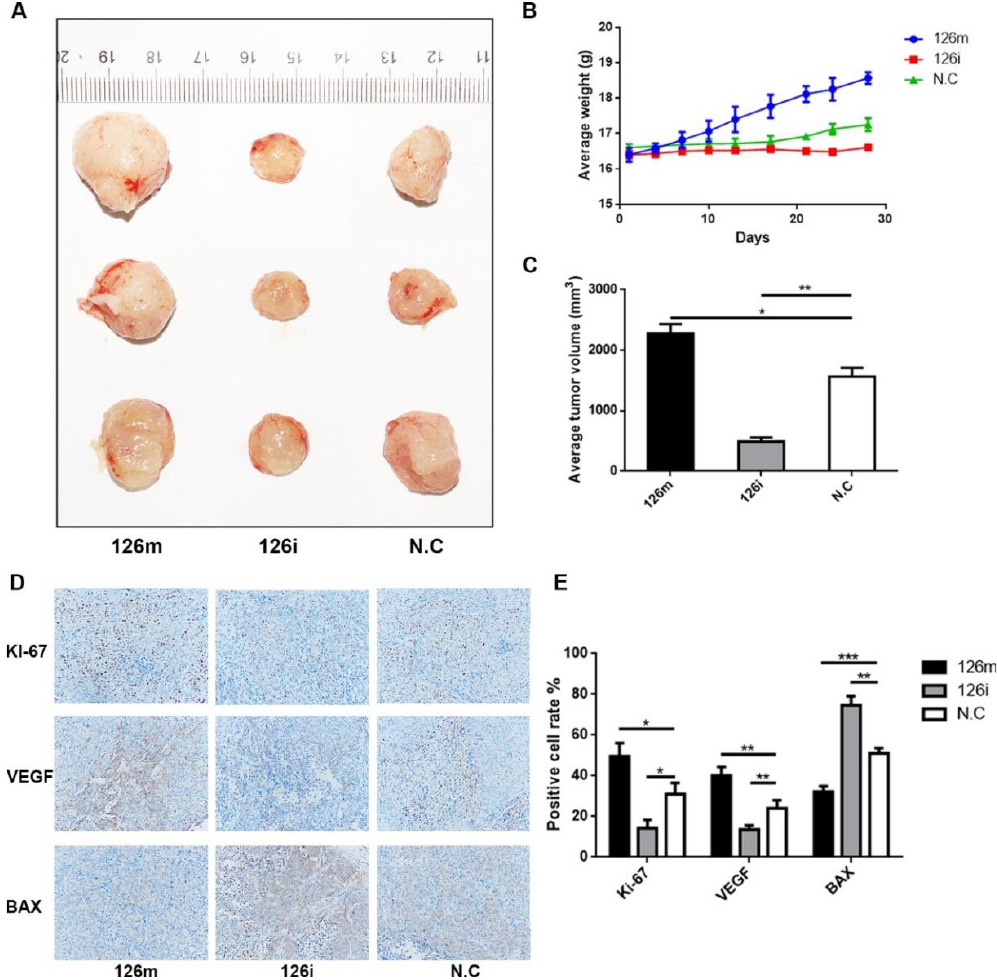
Figure 5. Verification of promotion effect of miR-126-5p in nude mice transplantation experiment. ( A ) BALB/c nude mice were taken for xenotransplantation, and the size was measured by the ruler. ( B ) The body weight of nude mice showed significant intergroup difference due to tumor size. ( C ) The volume of anatomized subcutaneous xenograft tumors was measured and analyzed by Student’s t test. ( D , E ) Representative Ki-67, BAX, and VEGF immunohistochemical staining micrographs of xenograft tumors. Ki-67 and VEGF were significantly increased in the group 126m, while BAX was signif- icantly reduced. The 126i group showed the opposite trend. Data are shown as mean ± SD, n = 3; * p < 0.05, ** p < 0.01 and *** p < 0.001 vs. NC.